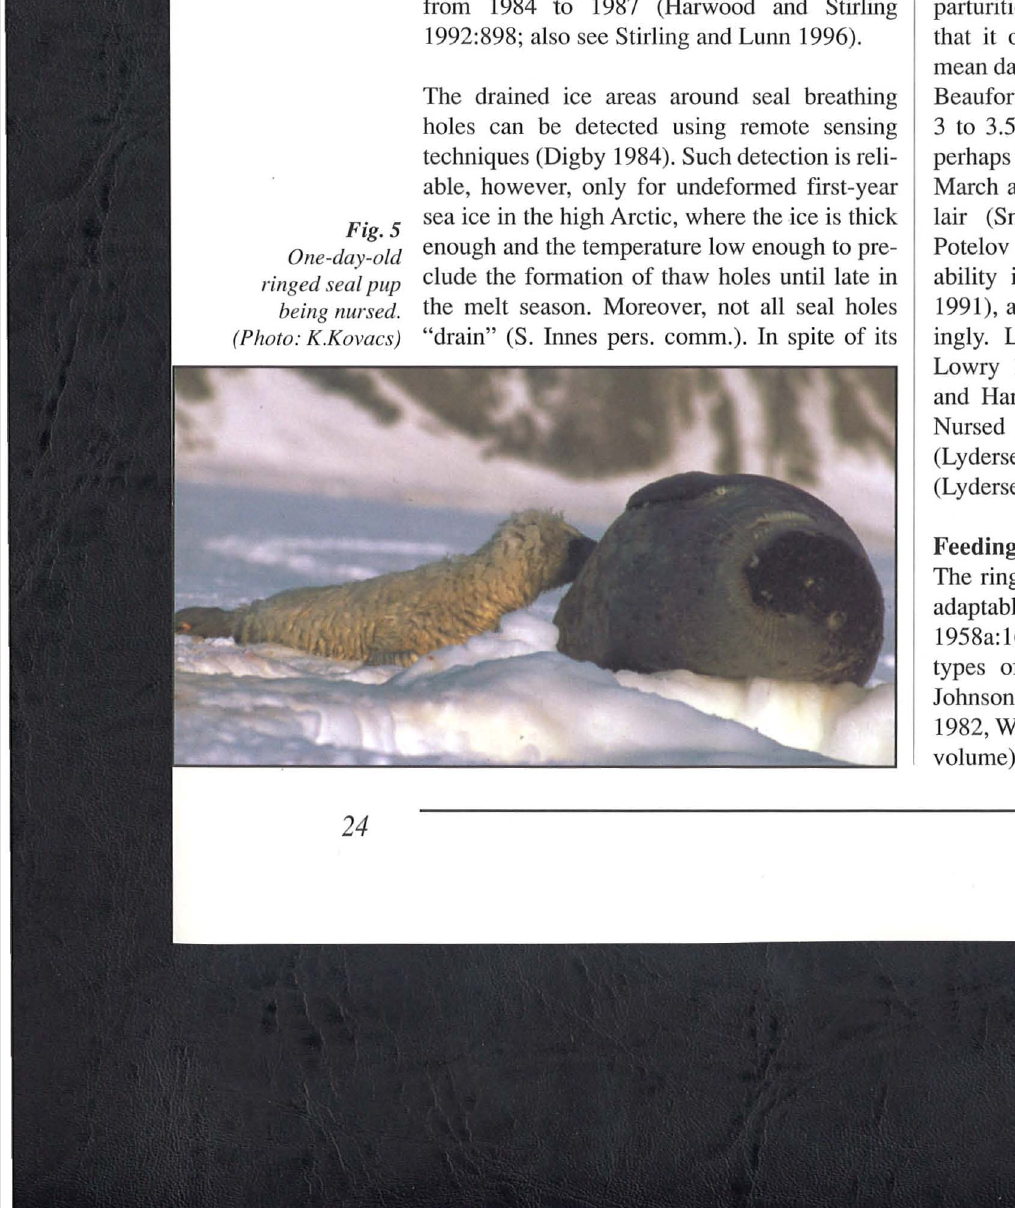
One-day-old ringed seal pup being